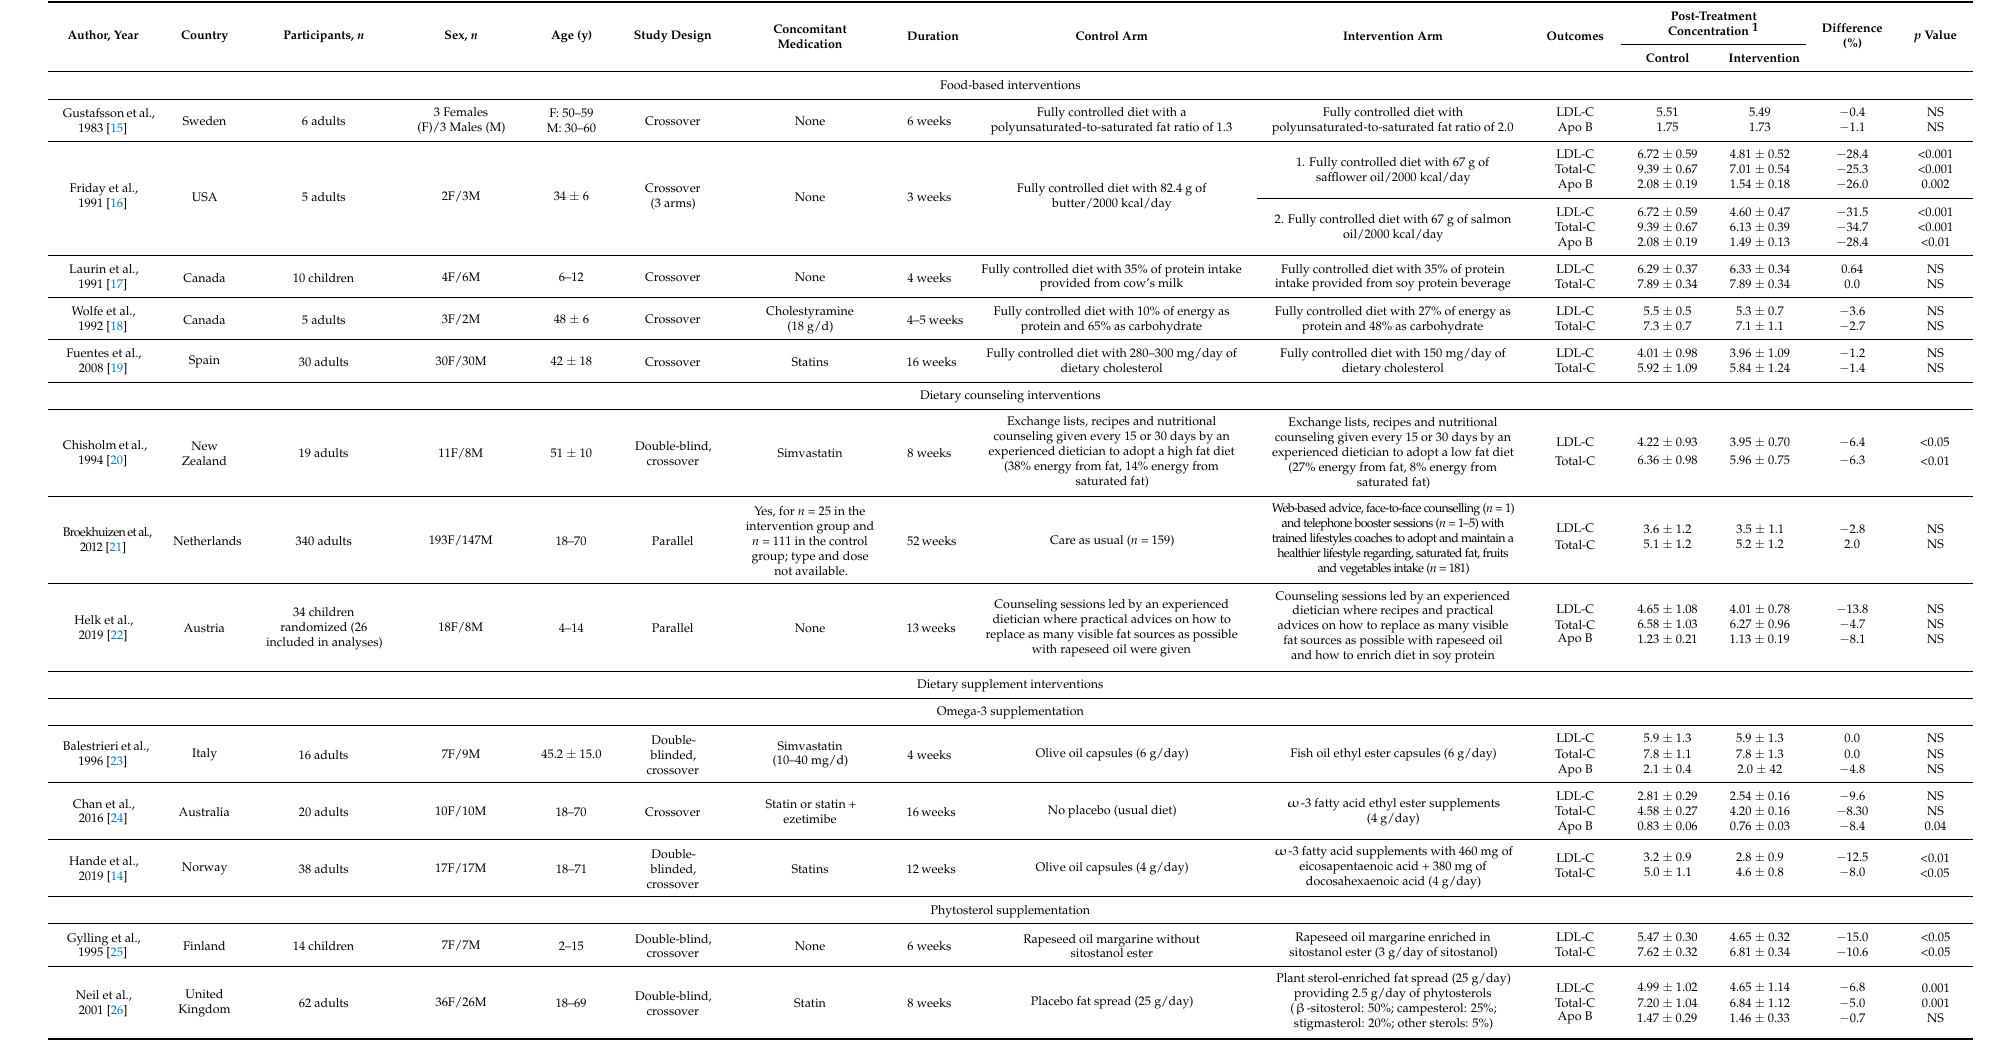
Table 1. Characteristics of studies included in the systematic